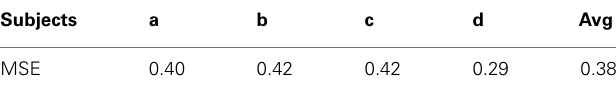
Table 2 | MSE on the evaluation data